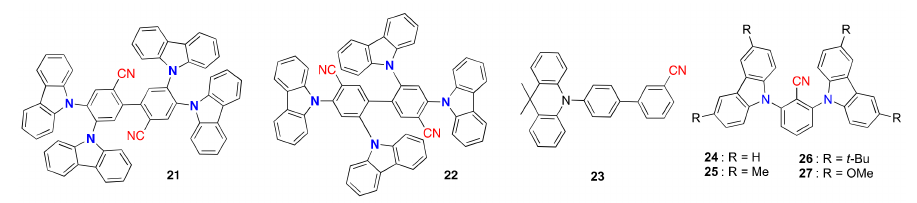
Figure 5. Cyano based emitters.